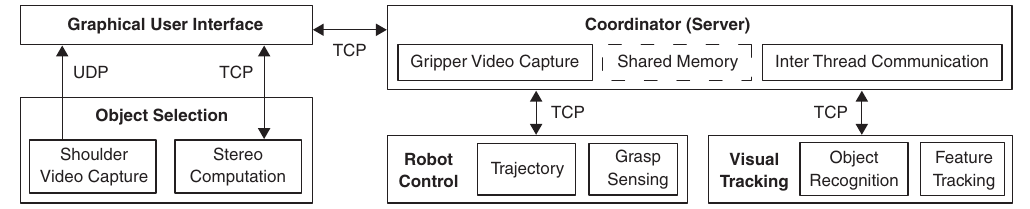
Fig. 3. Data flow of our direct-selection, human-in-the-loop visual control system for the Manus ARM.